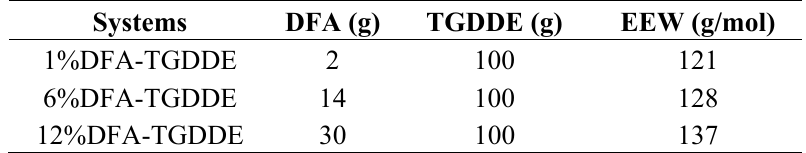
Table 4. The formula of DFA-TGDDE and their epoxy equivalent weight